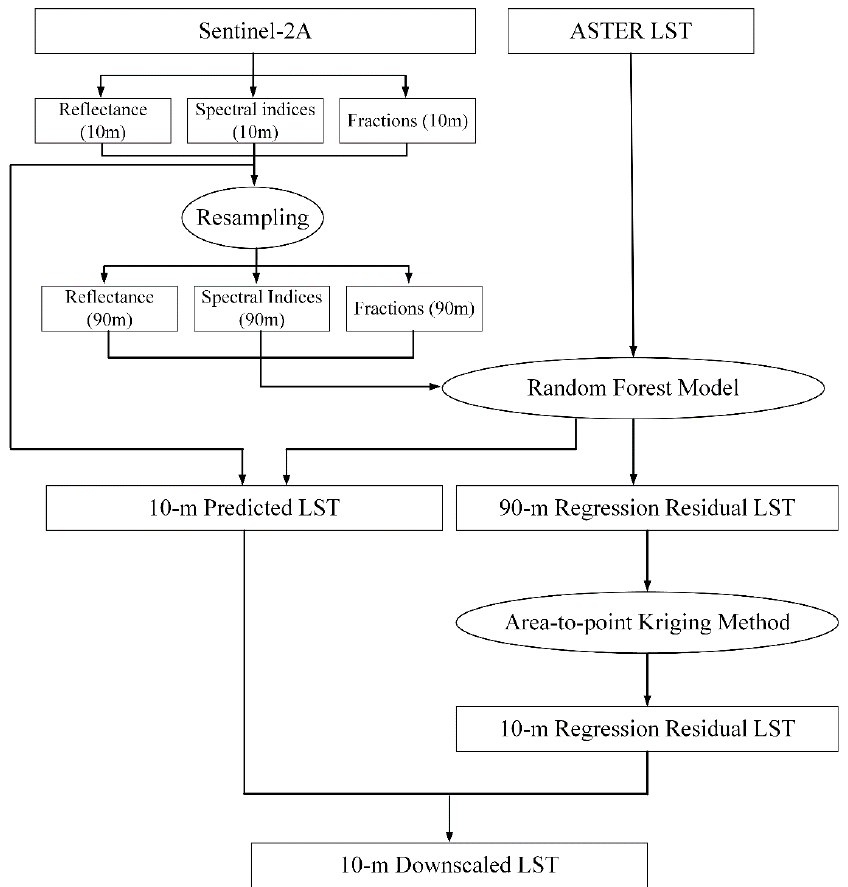
Figure 2. The downscaling procedure of ASTER land surface temperature (LST) using the machine learning-based geostatistical downscaling method (RFATPK).